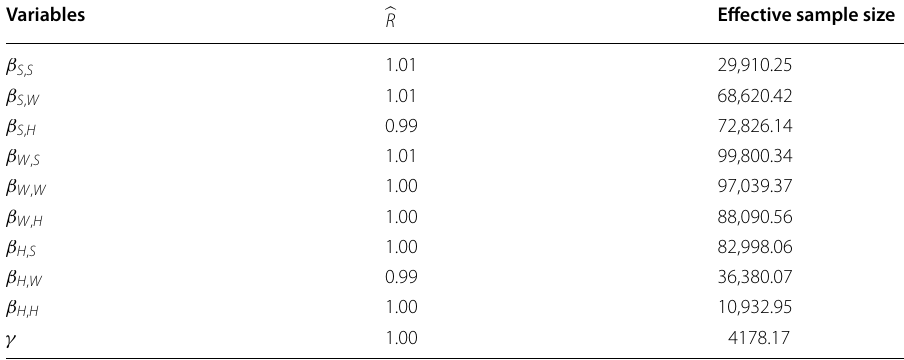
Table 3 Convergence diagnostic tests for BVAR parameters